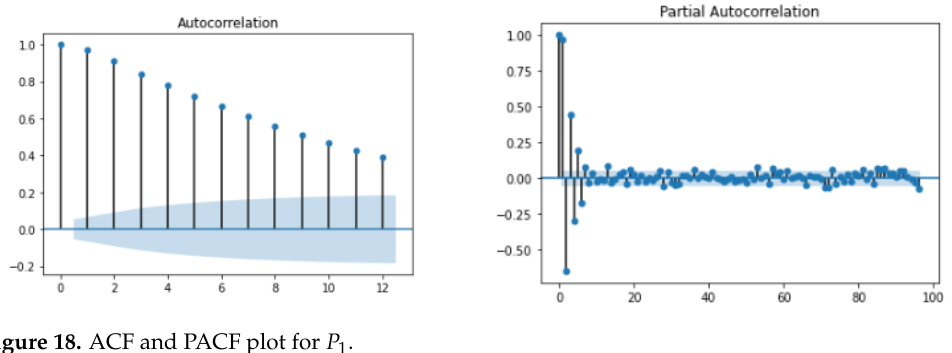
Figure 18. ACF and PACF plot for P 1